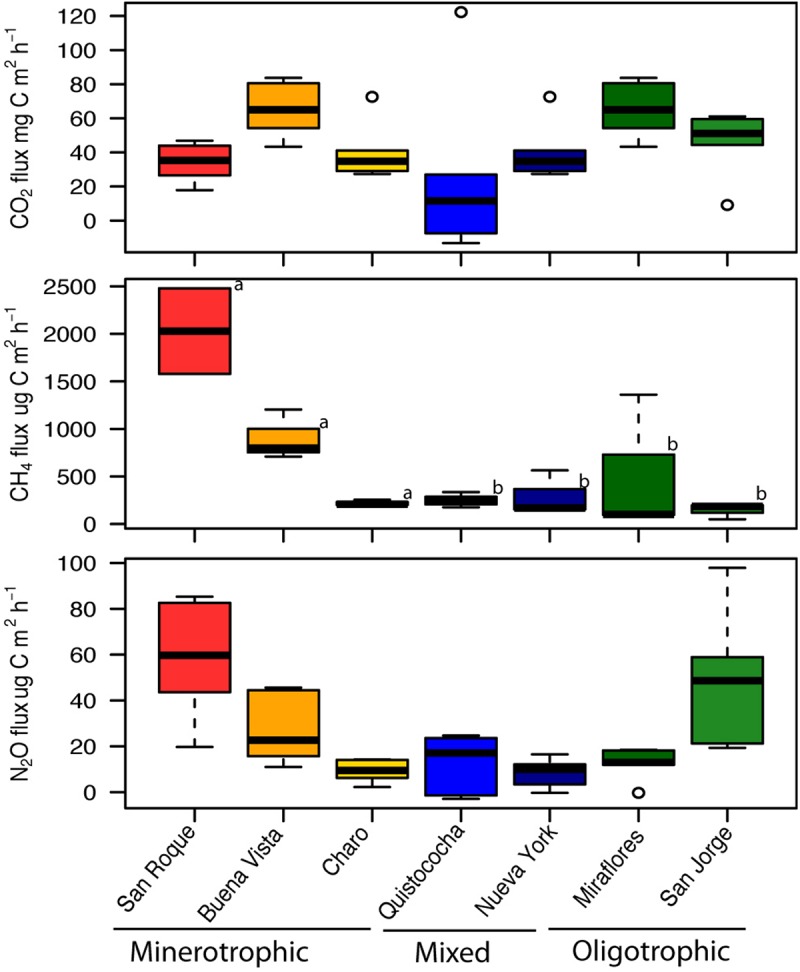
Greenhouse gas fluxes of CO2 (mg C m2 h–1), CH4 (μg C m2 h–1), and N2O (μg N m2 h–1) across the Pastaza-Marañón Basin. Box plots show the mean and quartiles of six independent measurements. All flux measurements were evaluated for statistically significant differences among categories with a Least Significant Difference post hoc test where different letters (a, b) indicate significant differences across site categories (minerotrophic, mixed and ombrotrophic) at the p = 0.05 level.